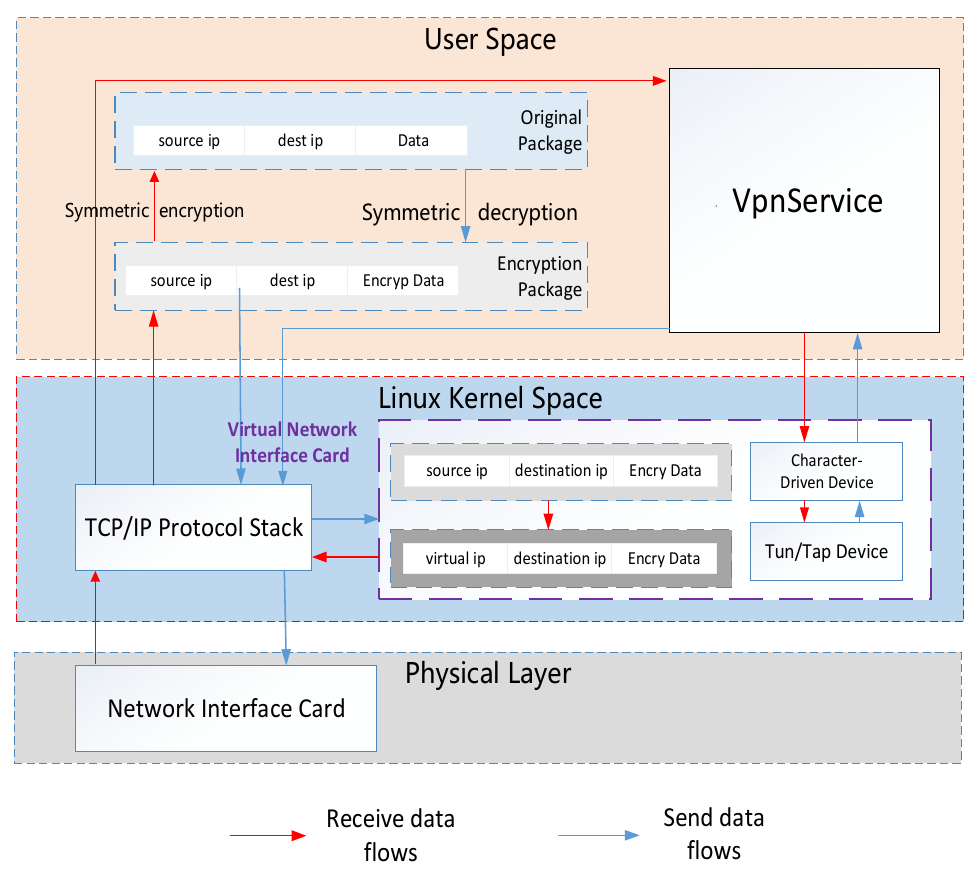
Figure 3. The overall data transfer framework.